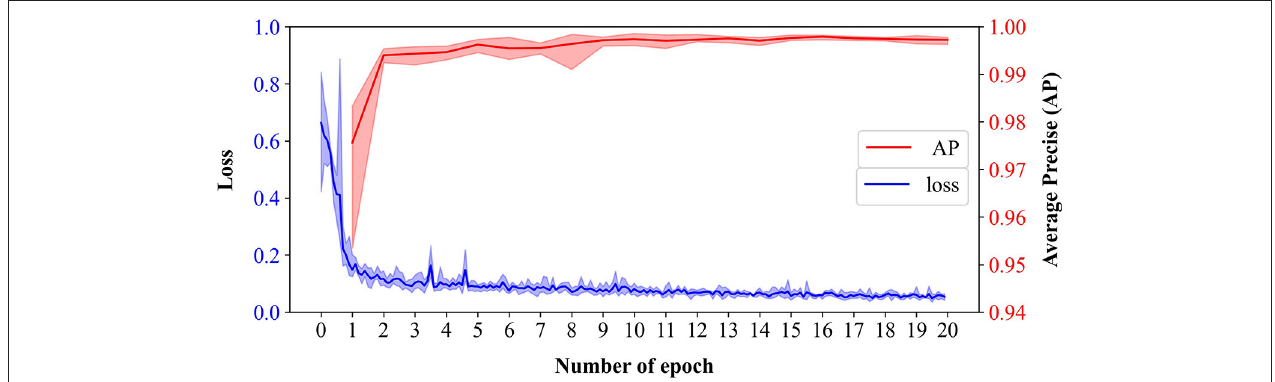
FIGURE 4 | The evolutionary curves of loss of training sets and average precision (AP) of validation sets of the Faster R-CNN-based model across 20 epochs from five-fold cross-validation. Bold lines represent the mean of loss (blue) and AP (red), and the translucent bands represent the range of loss and AP across five-fold.